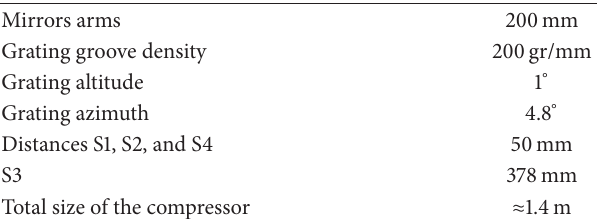
Table 3: Parameters of the compressor for the 70–140 eV spectral region.